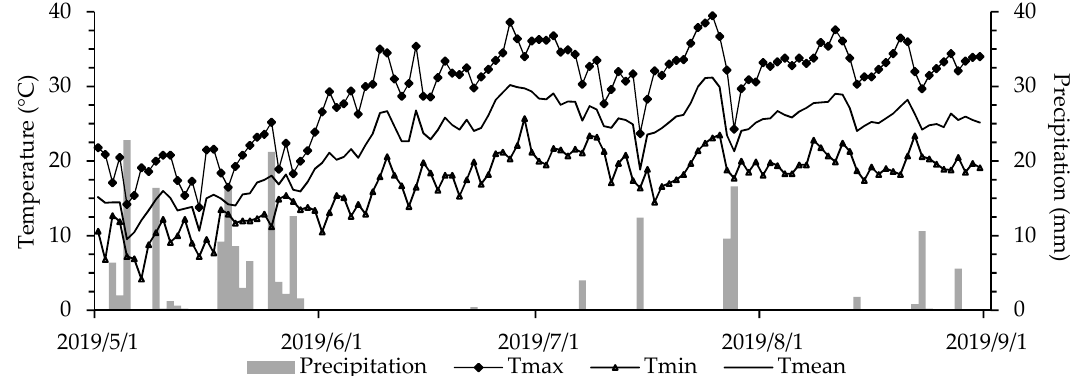
Figure 2. Meteorological data observed during the growing season.